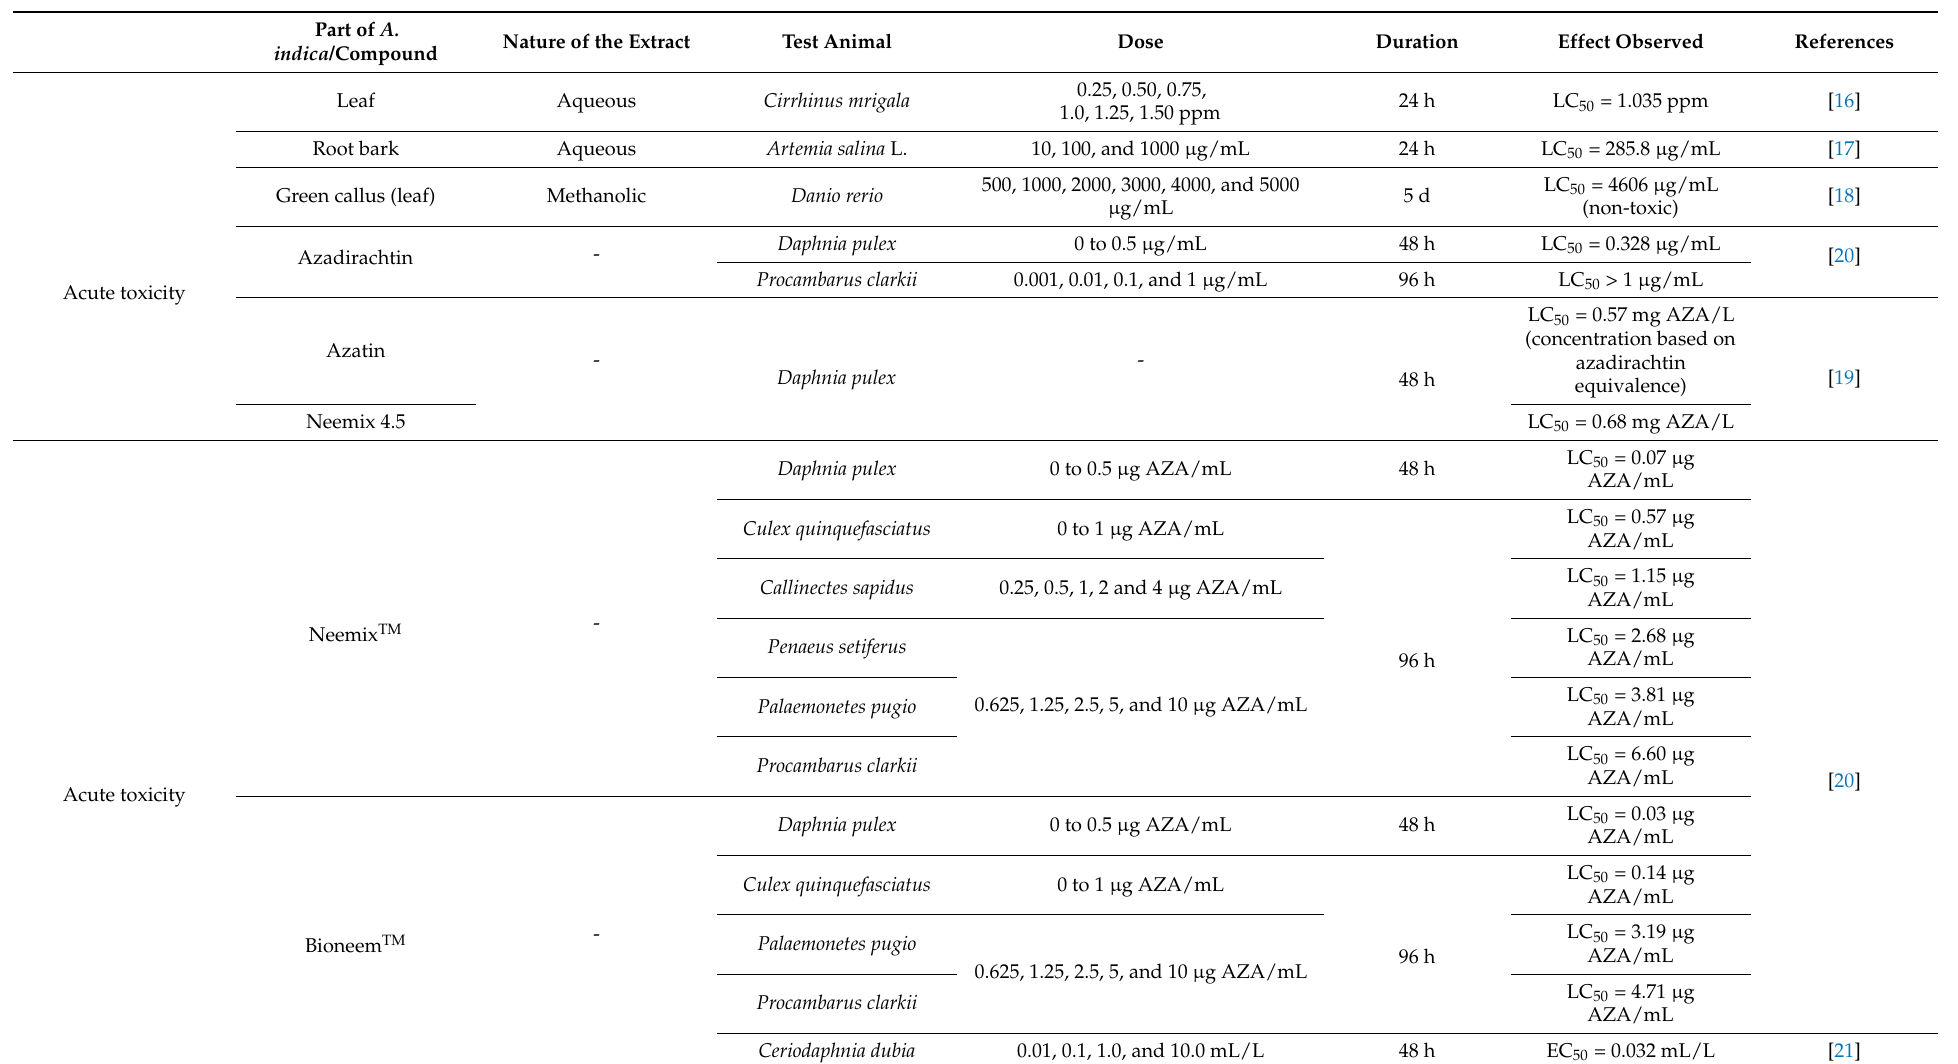
Table 1. Toxicity of neem in different aquatic